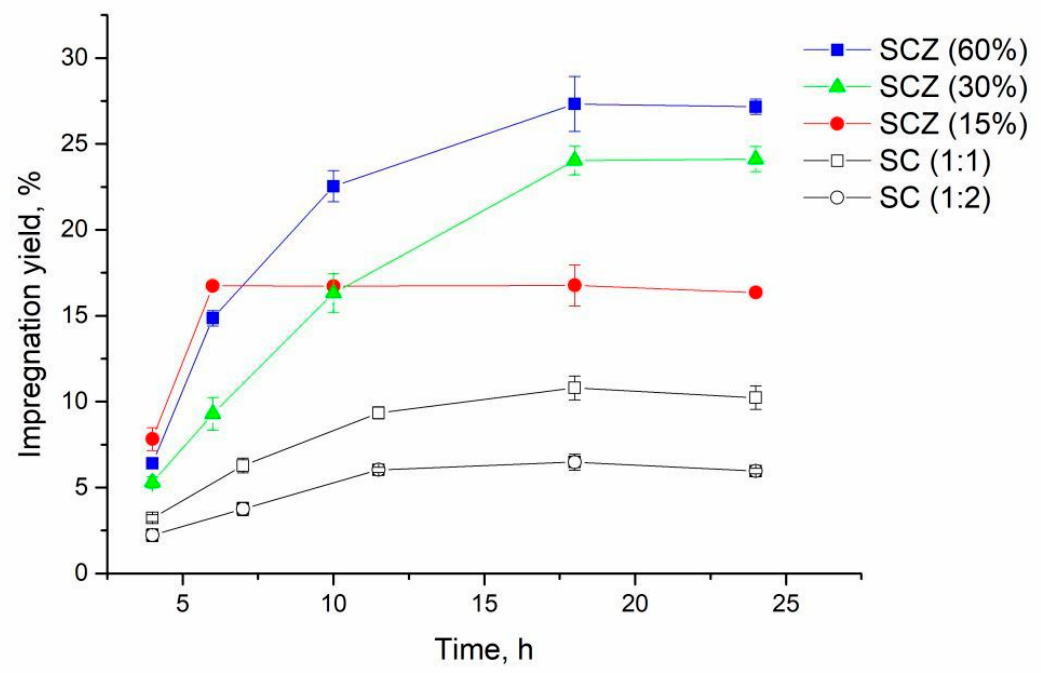
Figure 1. Kinetics for SC and SCZ films with 1:1 and SC films with 1:2 starch/chitosan mass ratios at 35 °C and 30 Mpa. Zeolite content is given in the brackets.